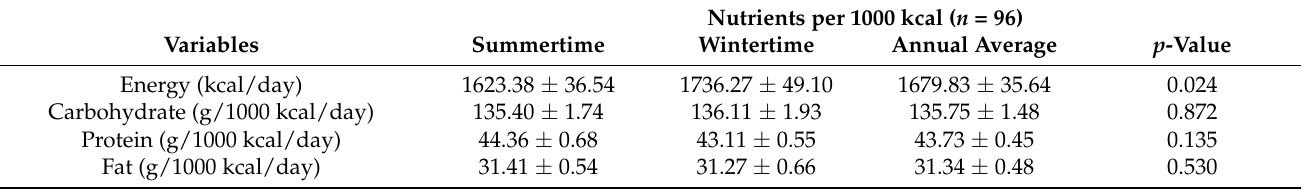
Table 3. Nutrient